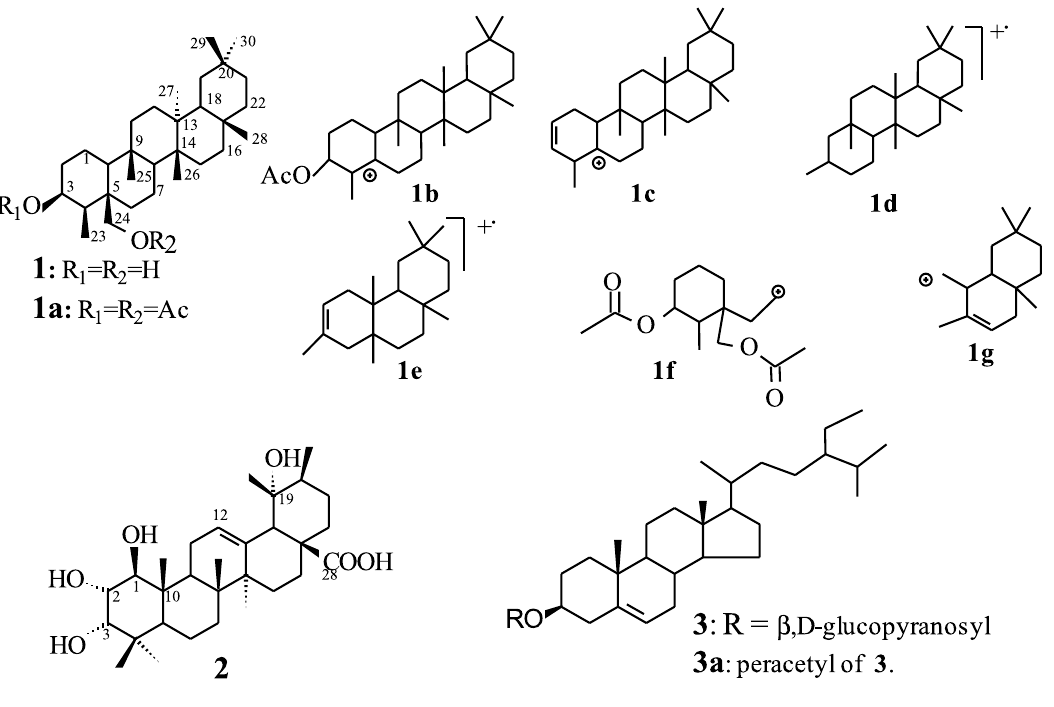
Fig. 1 – Structures for compounds isolated from E. longipes , acethyl derivatives and for prominent peaks in the HRMS.